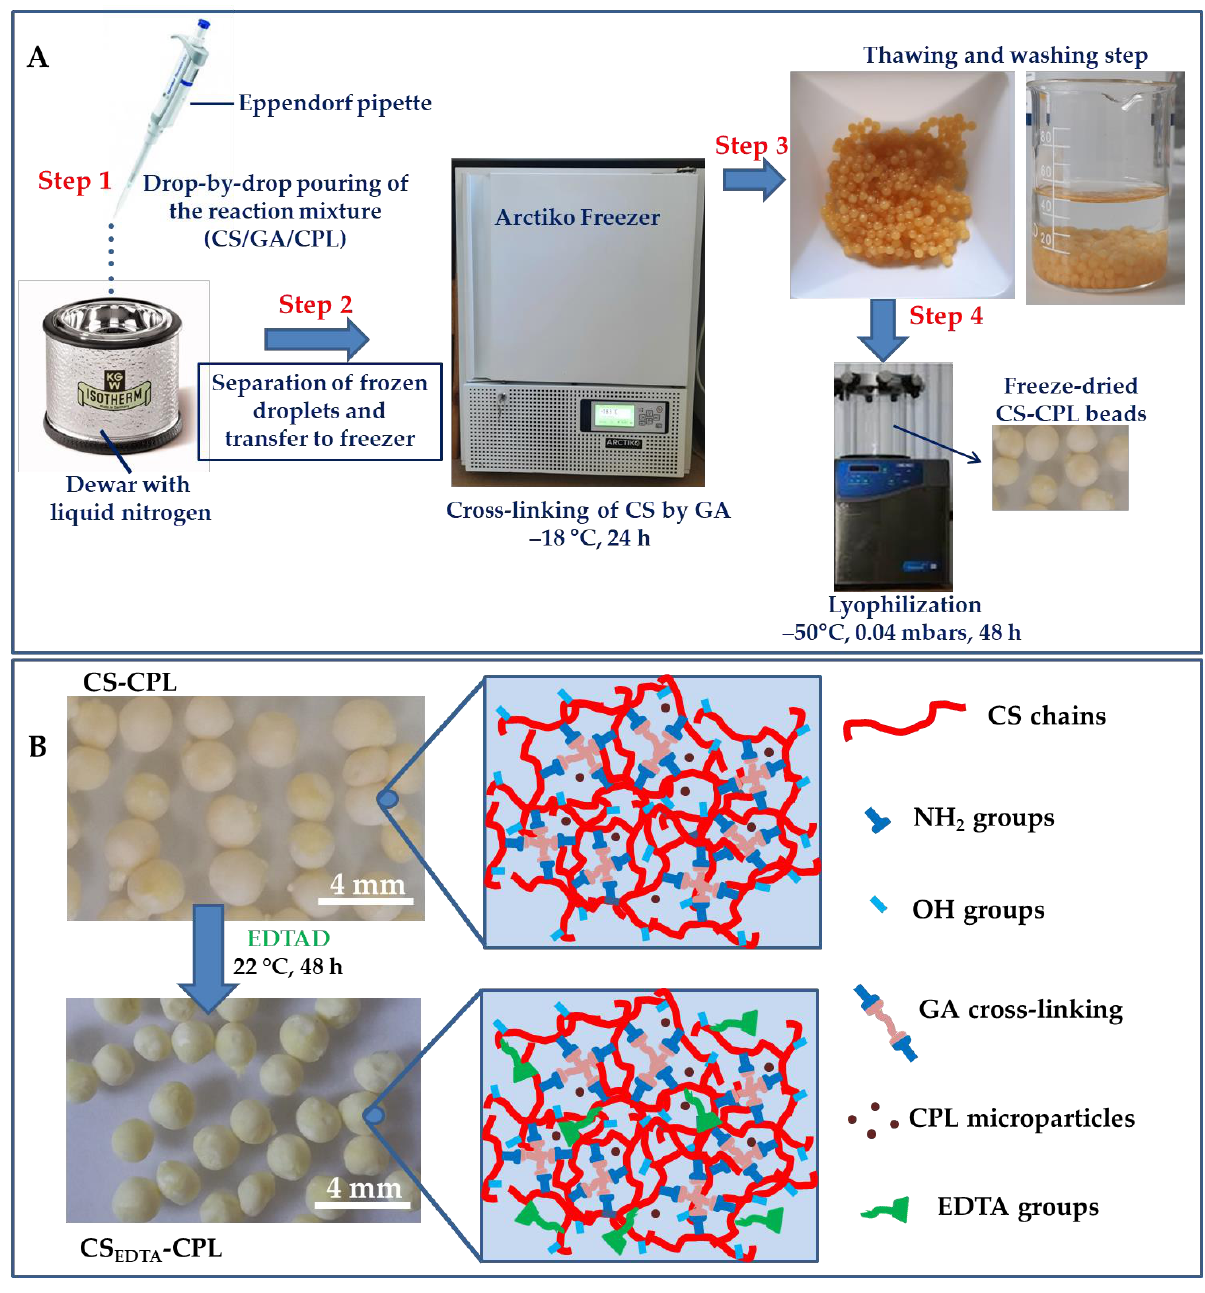
Figure 2. ( A ) A schematic procedure of the preparation of CS-CPL sorbents. ( B ) Optical pictures showing freeze-dried CS-CPL microbeads before and after interaction with 4, 4′– ethylenebis(2,6 – morpholinedione) (EDTAD) and schematic illustration of –NH 2 , -OH, and EDTA functional groups available within CS-CPL and CS EDTA -CPL composite sorbents available for interaction with HMIs. Table 1. EDX elemental atomic composition of CS-CPL and CS EDTA -CPL microbeads surface.